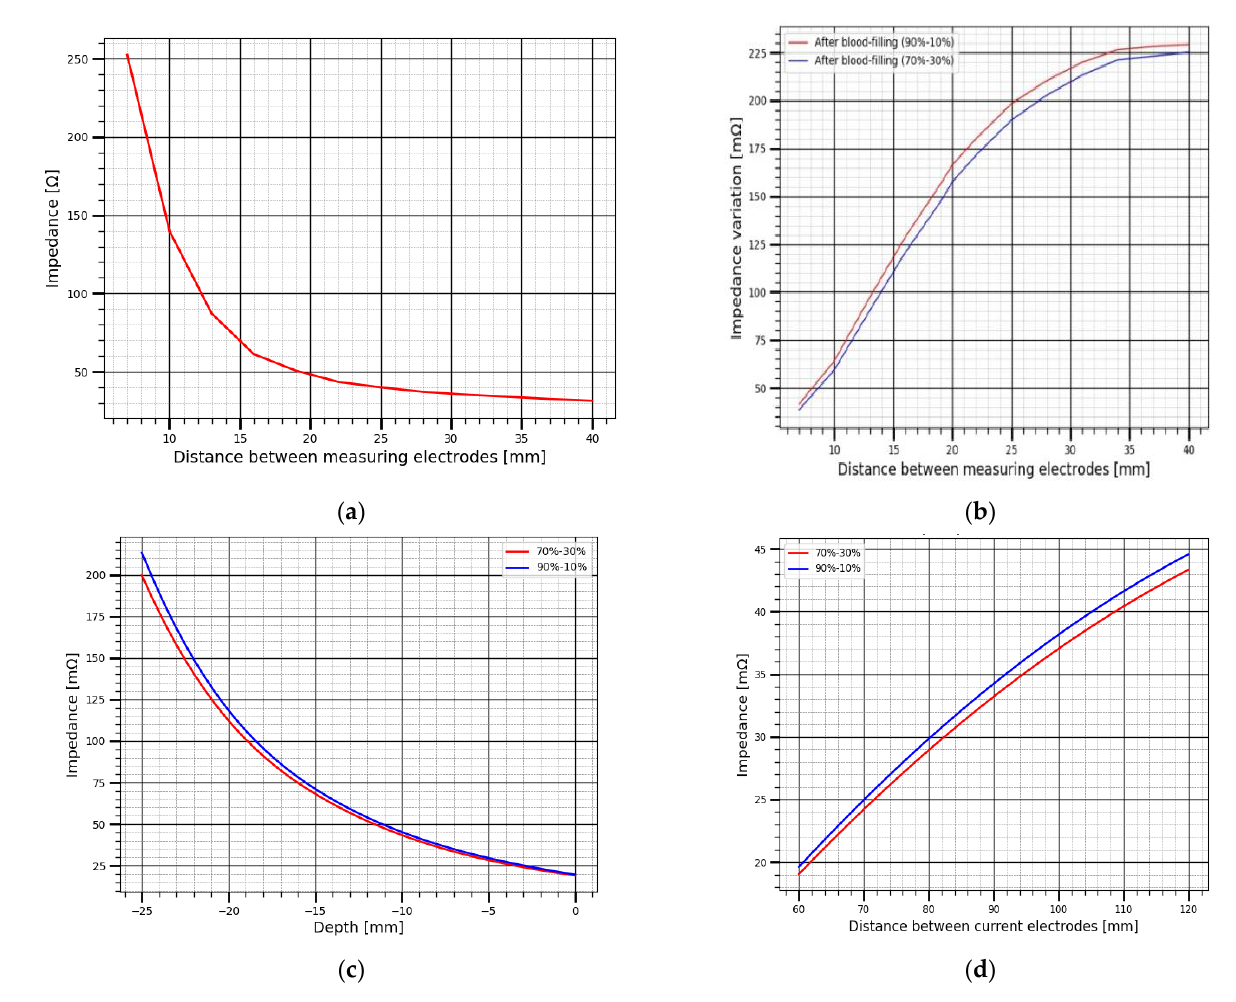
Figure 7. The change of electrical impedance obtained by numerical modelling: ( a ) the variation of static impedance with increasing distance between measuring electrodes, ( b ) the variation of pulsatile impedance with increasing distance between measuring electrodes, ( c ) the variation of pulsatile impedance with increasing kidney depth, ( d ) the variation of pulsatile impedance with increasing distance between measuring electrodes at the maximum kidney depth. Table 5. The obtained electrical impedance values during the numerical modeling. Distance